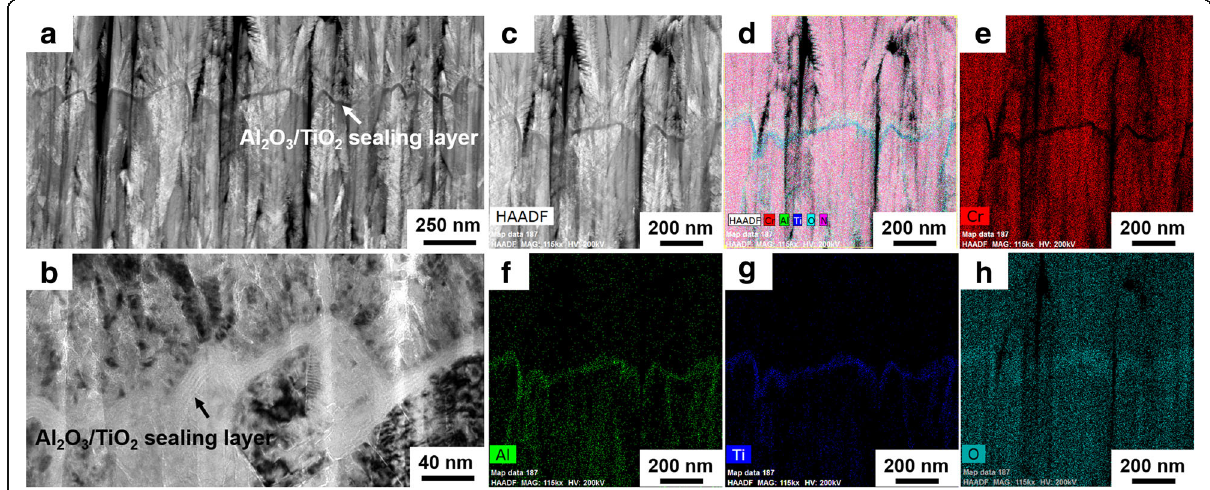
Fig. 4 TEM/HRTEM/EDX analysis of the typical CrN-Al 2 O 3 /TiO 2 hybrid coating: a low magnification bright field image. b HRTEM image of the nanolaminate-Al 2 O 3 /TiO 2 sealing layer. c-h EDX mapping results of Cr, Al, Ti and O